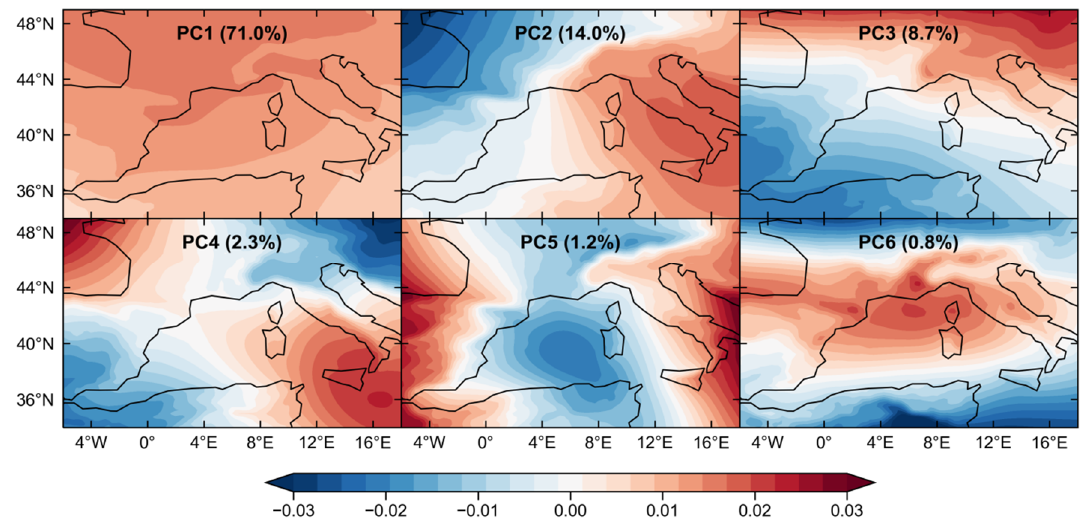
Figure 3. Leading modes (principal components, PC) of the mean sea level pressure (mslp in Pa, shaded) over the time period 1980–2018, and explained variances.